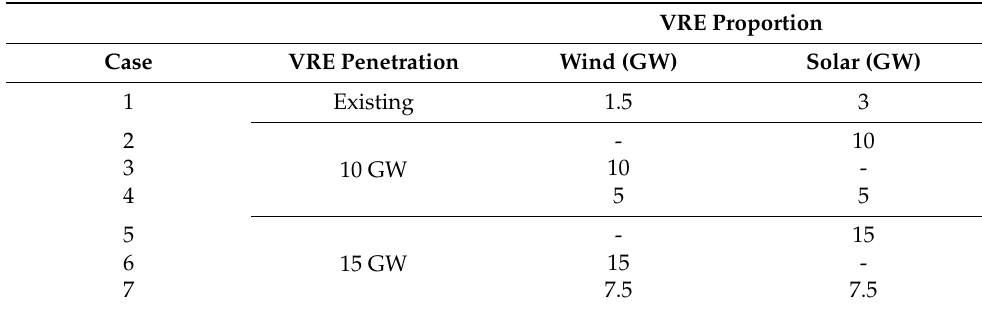
Table 3. VRE penetration and proportions for sensitivity analysis.